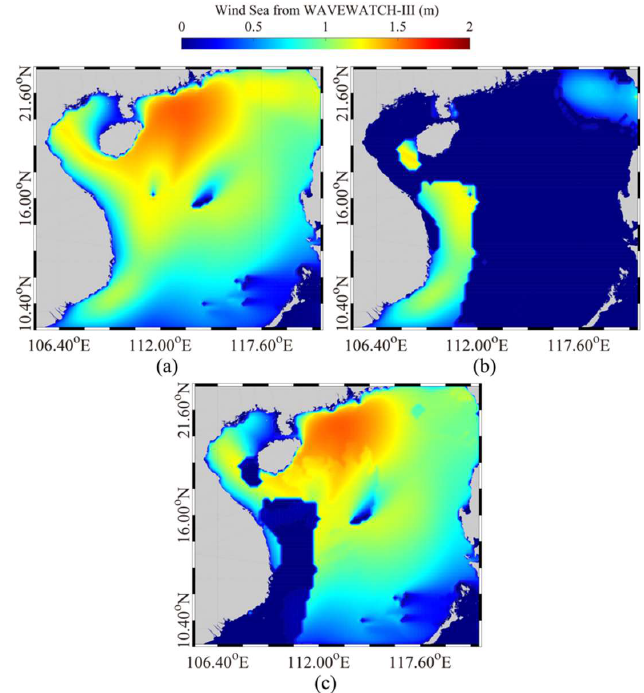
Figure 10. The distribution of wave at 6:00 a.m. UTC on 16 September 2017 during Typhoon Doksuri. ( a ) the distribution of total SWH; ( b ) the distribution of wind-sea portion; ( c ) the distribution of swell portion.